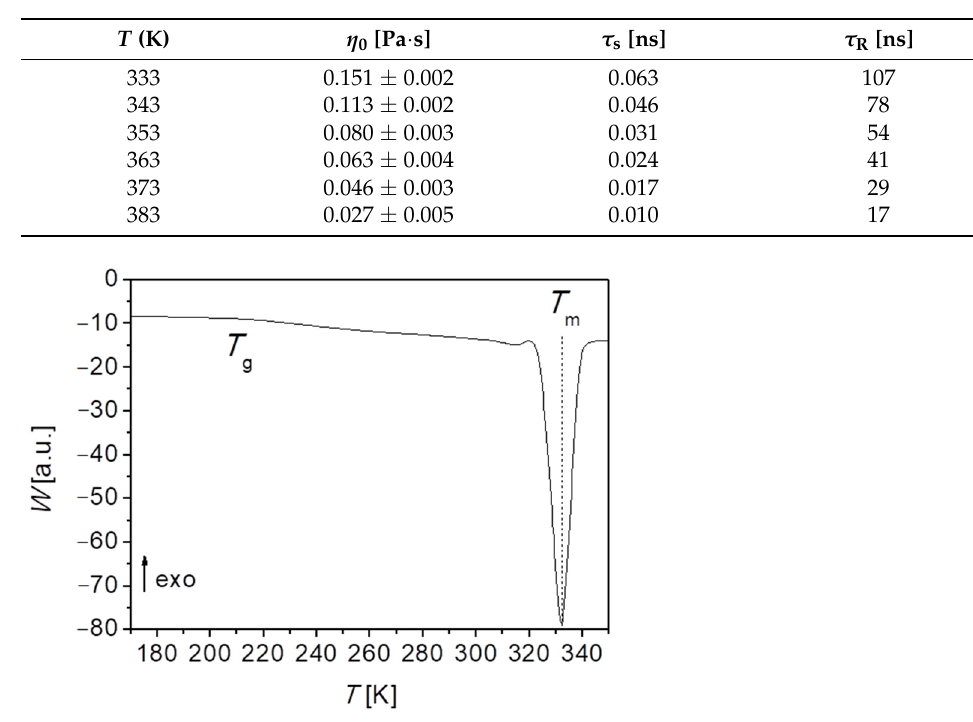
Figure 1. DSC thermogram for PEG polymer obtained at a heating rate of 10 K/min, showing the glass transition ( 𝑇 (cid:2917) ) and melting temperatures ( 𝑇 (cid:2923) ), with increasing temperature, respectively, indicated by the dotted